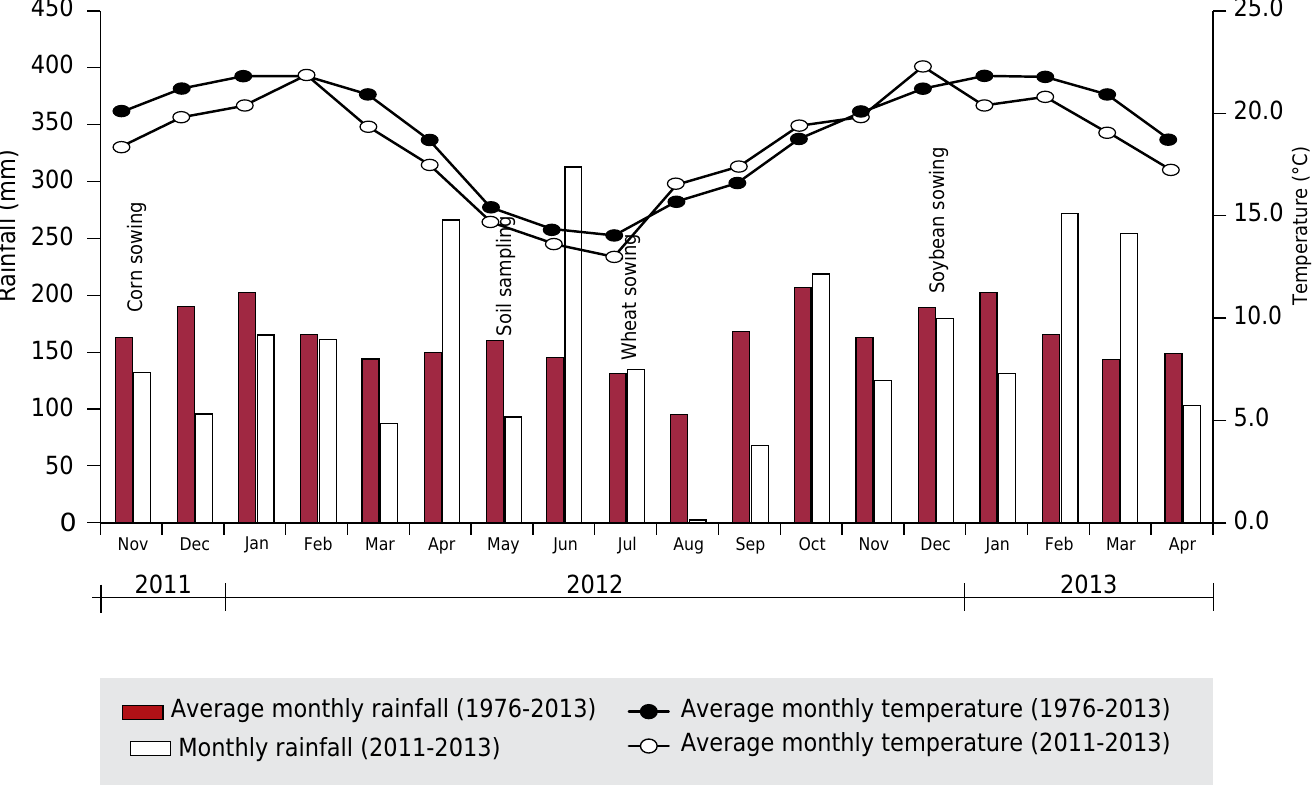
Figure 1. Monthly rainfall and temperature for the periods of 1976-2013 (long-term averages), and November 2011 to April 2013 (experimental period) in Guarapuava, Paraná state,